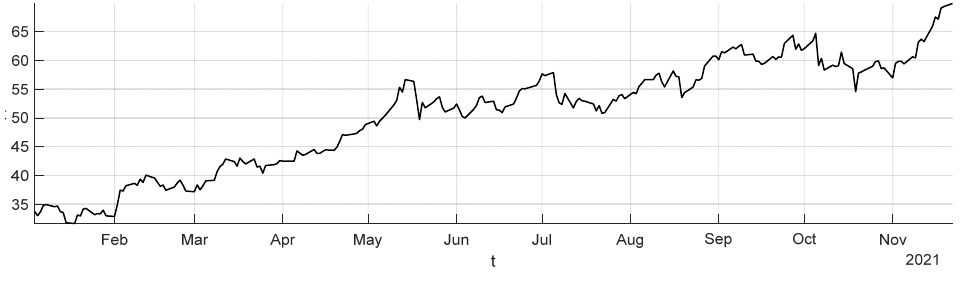
Figure 3. Daily observation of carbon price (EUA).